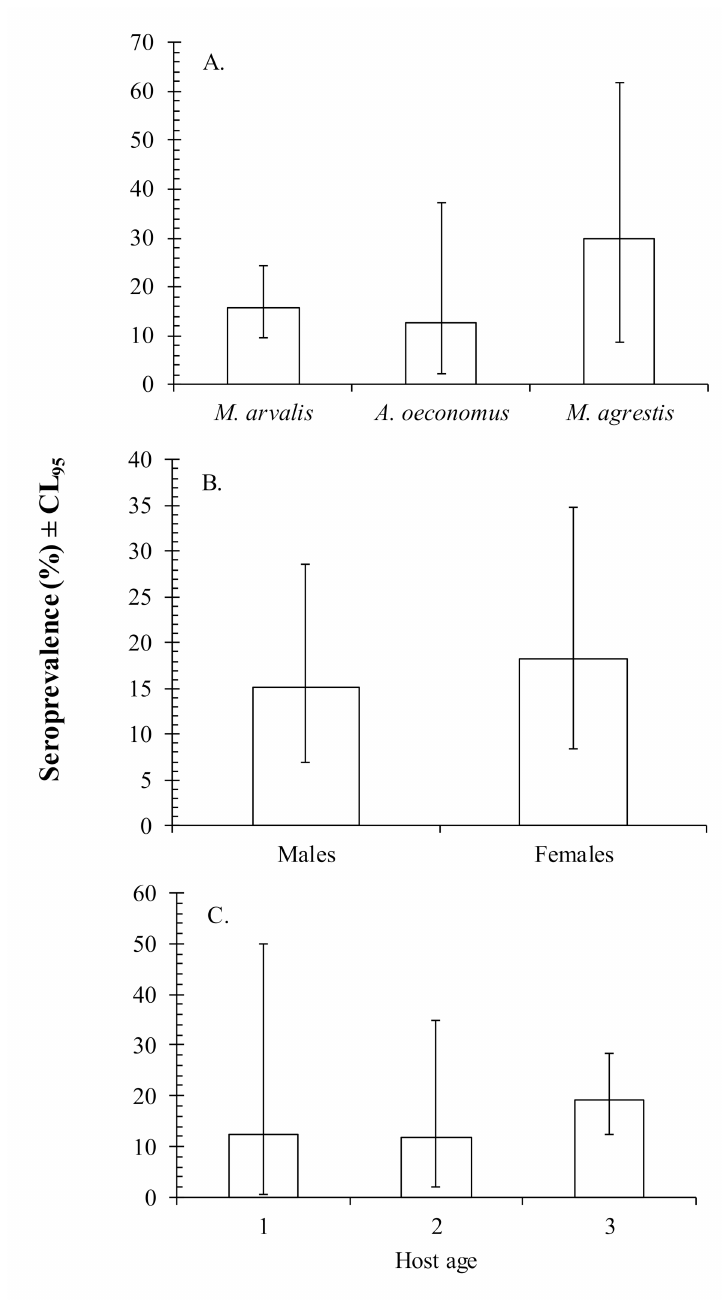
Figure 1. Seroprevalence of cowpox virus within: ( A ) three vole species; ( B ) host sex; ( C ) host age. Number of animals sampled: Microtus arvalis ( n = 51); Alexandromys oeconomus ( n = 16); Microtus agrestis ( n =